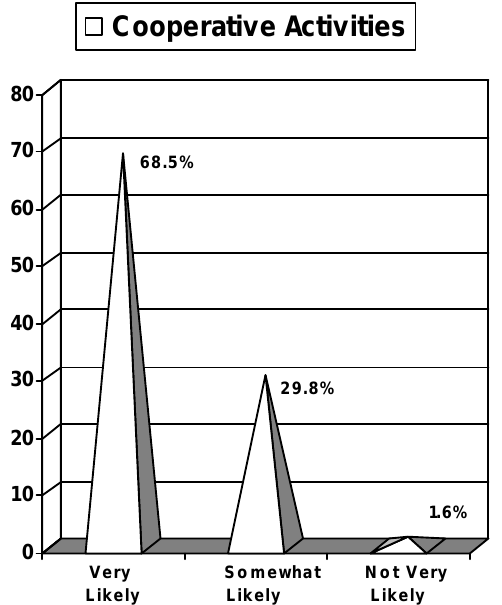
Figure 2. Likelihood of positive youth development with cooperative activity